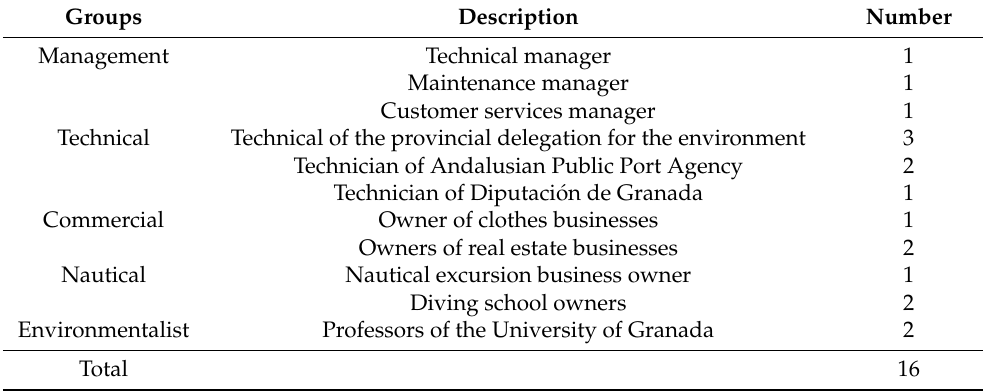
Table 1. Groups and participants